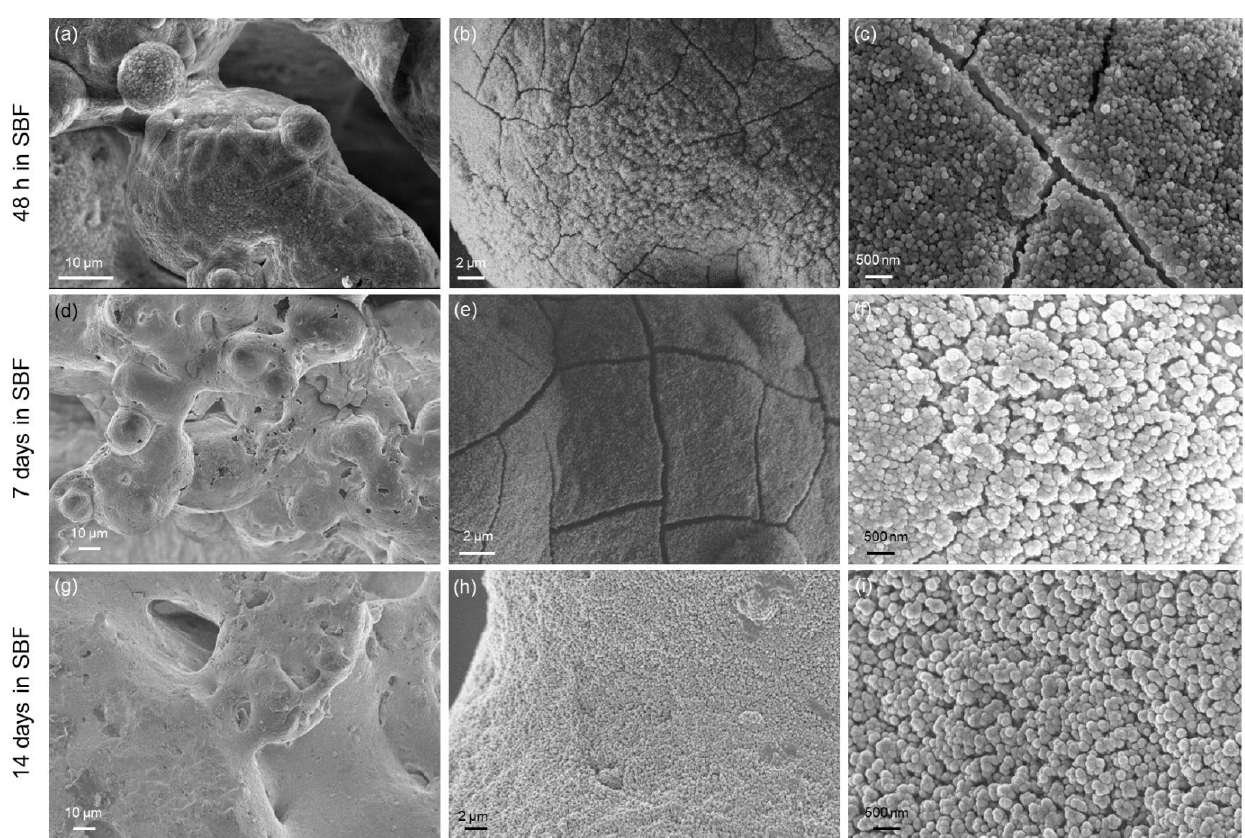
Figure 7. In vitro bioactivity tests: surface of scaffold struts at increasing magnifications after immersion in SBF for ( a – c ) 48 h, ( d – f ) 1 week, and ( g – i ) 2 weeks.